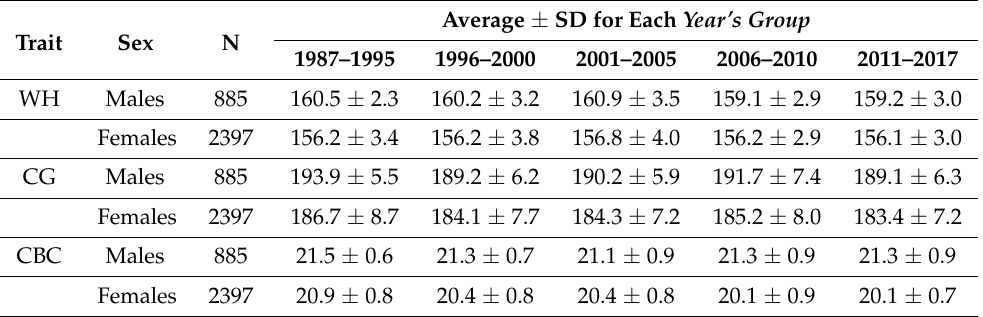
Table 8. Trend of variation, assessed from 1987 to 2017, for wither height ( WH ), chest girth ( CG ) and cannon bone circumference ( CBC ), expressed as mean and standard deviation (SD), both for males and females, in five subsequent periods of about five years